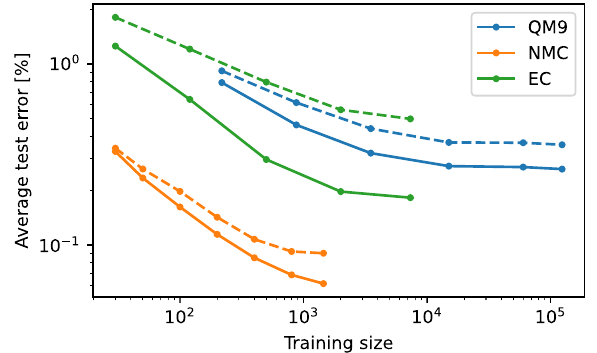
Fig. 5 Learning curves for invariant (dashed lines) and equivar- iant (solid lines) models for three different datasets. The plot shows the average normalized test errors (Equation 1) for the QM9 (blue) LIB Cathode (orange) and Ethylene Carbonate (green) datasets as functions of the number of training examples, which are randomly sampled subsets of the full training